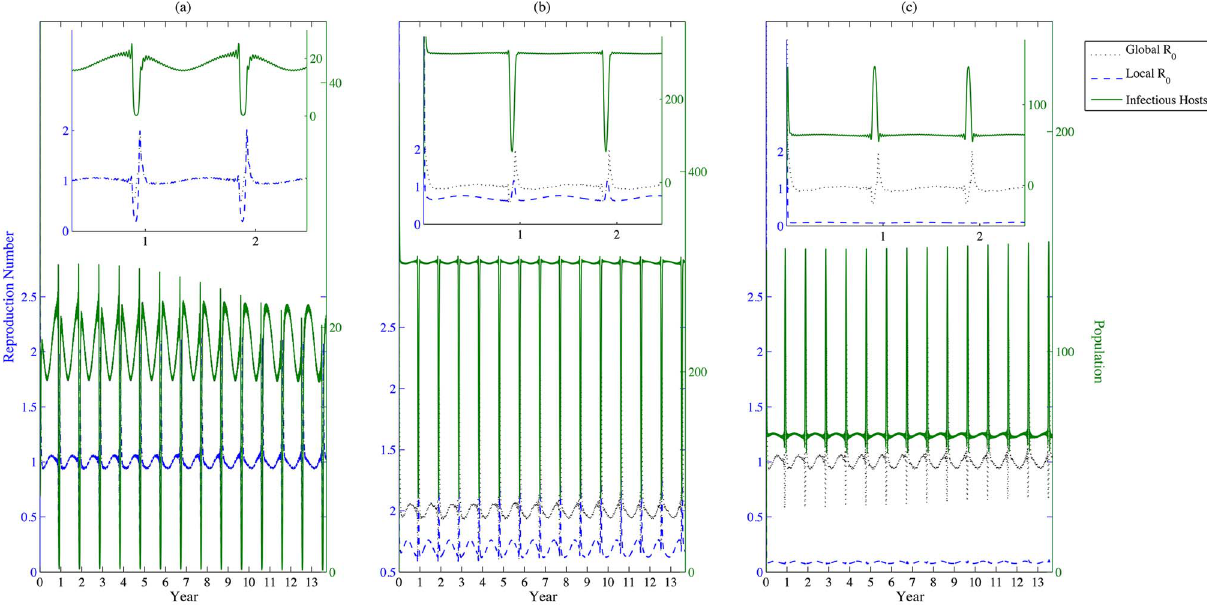
Fig. 5. Basic reproduction number. (a), (b) and (c) represent the populations of infectious livestock (solid line), the instantaneously local basic reproduction number (dashed line) and the instantaneously global basic reproduction number (dotted line) in patches 1, 2 and 3, respectively. Values of other parameters are identical with those in Fig. 3. The instantaneously global basic reproduction number is computed by considering the three patches as an entirety, while the instantaneously local basic reproduction number is measured only within the local patch based on the current disease dynamics.